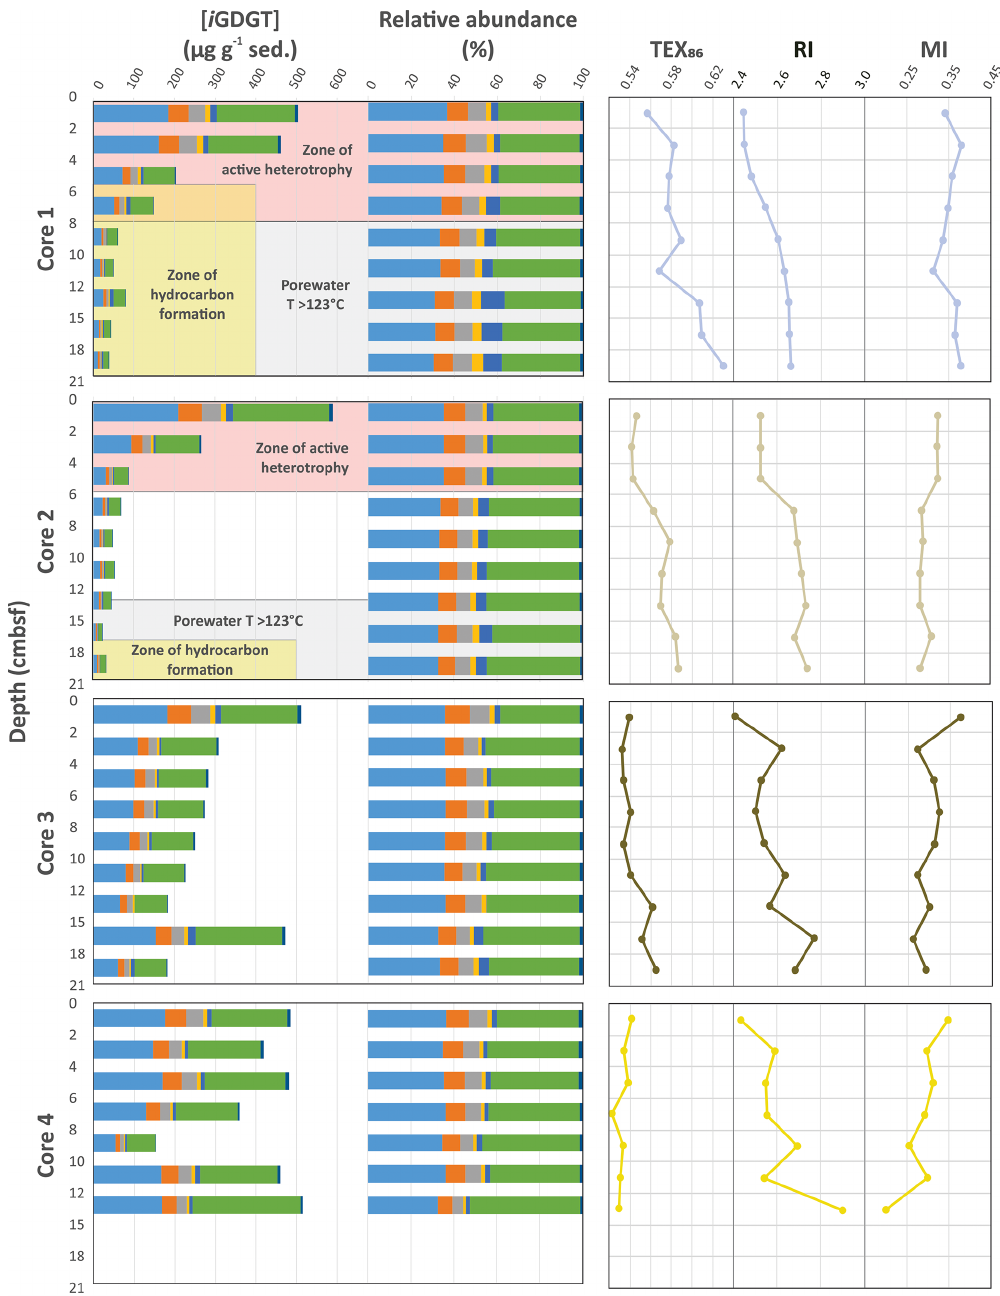
Figure 2. Downcore profiles of the Cathedral Hill core iGDGT absolute and relative lipid abundances and their generated iGDGT proxies: TEX 86 , RI, and MI. The pink background indicates transect intervals within zones of active GDGT lipid heterotrophy (Bentley et al., 2022). The gray background indicates transect regions where porewater temperatures exceeded 123 ◦ C, marking the known upper thermal limit of life (Kashefi and Lovley, 2003). Yellow fields are zones where oil generation and hydrocarbon degradation occur (Dalzell et al., 2021).